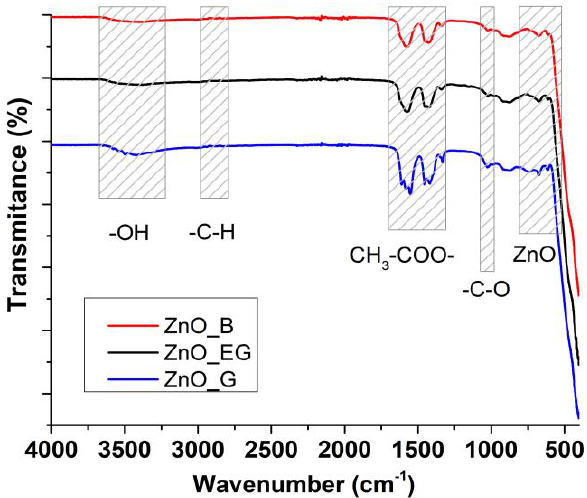
Figure 6. The FTIR spectra for ZnO_B, ZnO_EG and ZnO_G samples.